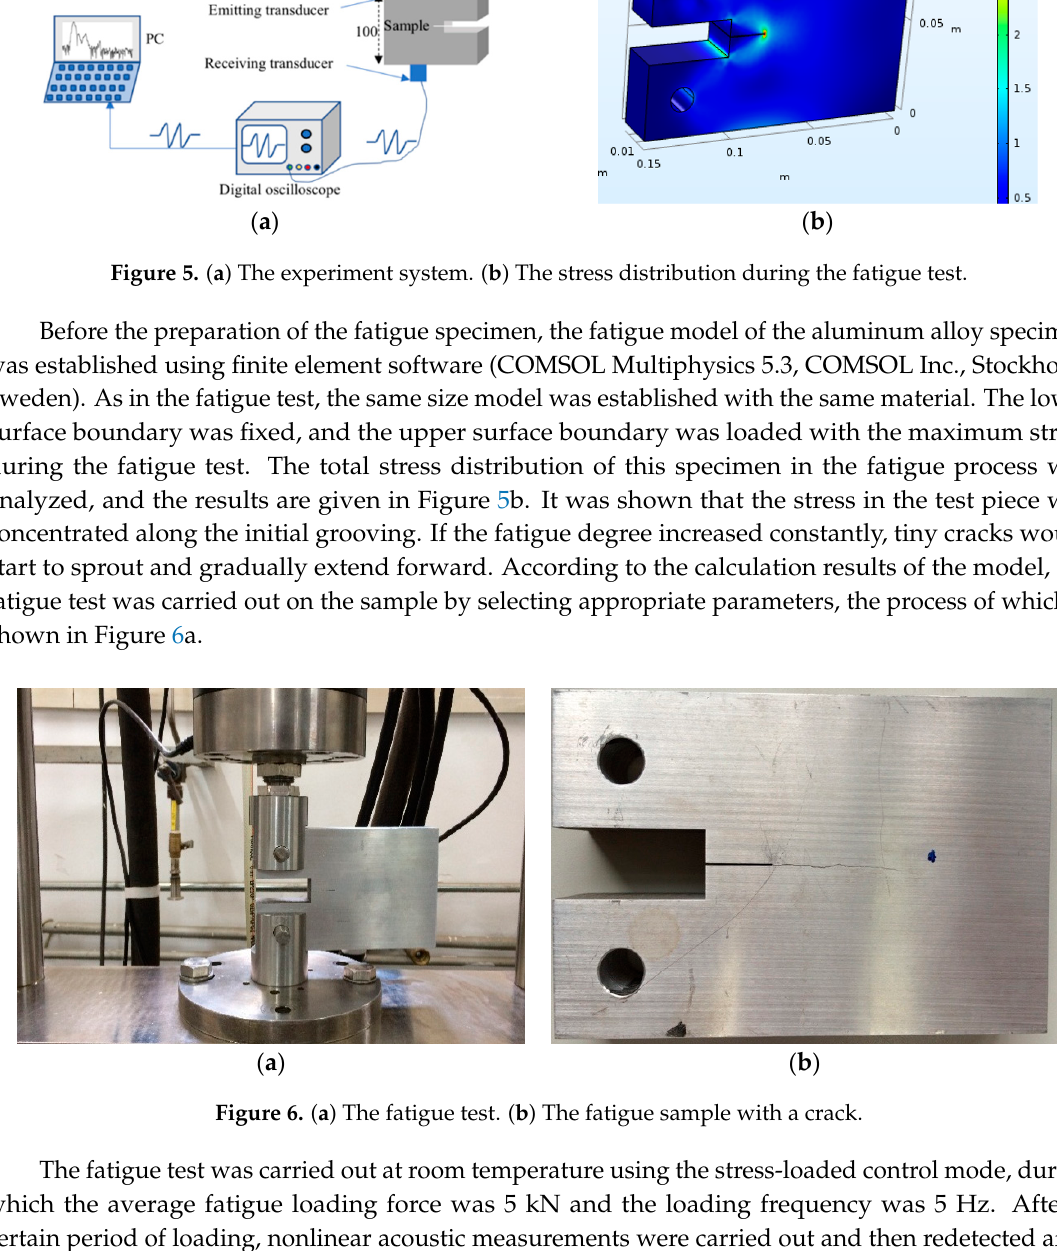
(d) Figure 4. Amplitude variation of (a) the fundamental wave A 1 , (b) the second-order harmonics A 2 , (c) the third-order harmonics A 3 , and (d) the fourth-order harmonics A 4 during the fatigue process, which is expressed by dislocation density for early stage and spring stiffness for the later stage. The above results show that acoustic nonlinearity is very weak for materials without damages, as given in Figure 4c, while the dislocation density is zero. However, with the increase of dislocation density, which means the deepening of fatigue damage, acoustic nonlinearity becomes much heavier. The fundamental wave amplitude is going to decrease, while harmonic amplitudes begin to rise due to the energy distribution law that energy transfers from the lower order signals to the higher orders, as shown in Region I in Figure 4a,c. Then, acoustic nonlinearity indicates the fatigue degree in materials during the early fatigue stage. Micro-cracks sprout with further fatigue loading, and the value of spring stiffness begins to drop, whose effects on each order harmonic are much heavier than that of the increasing dislocation density, so the harmonic amplitudes are going to decrease, as shown in Region II in Figure 4b,d. The energy of each order transmitted wave declines very quickly with the decreasing stiffness, owing to the rapid expansion of cracks in Region III. 3. Experiment Results and Discussions Based on the above analysis for the theoretical models during the fatigue process, the following